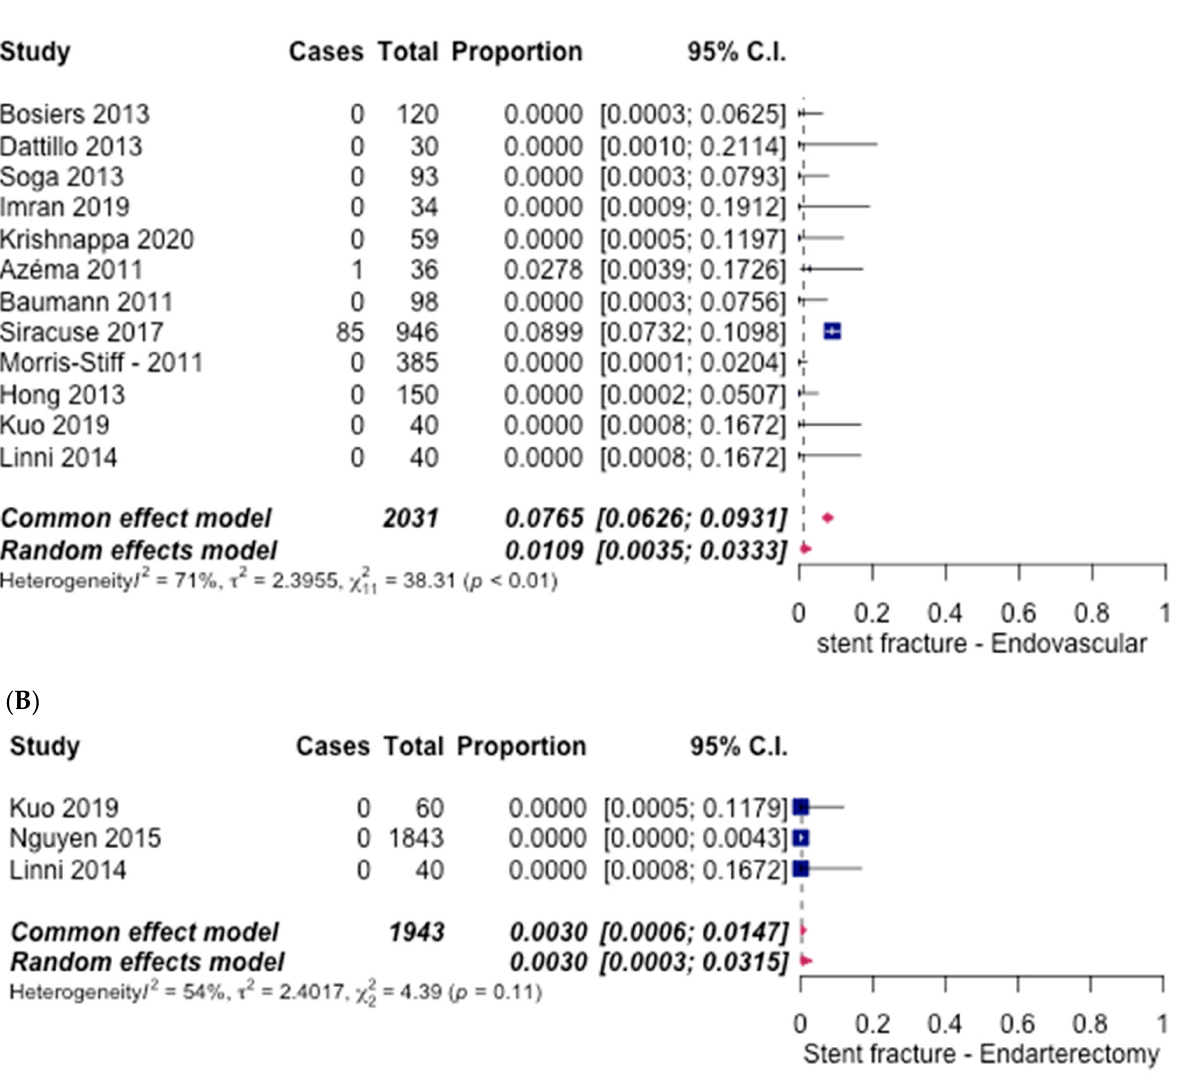
Figure 14. Forest plot for stent fracture. ( A ) Endovascular intervention [6,8,10,12,14–21]. ( B ) Endarterectomy [6,21,29].